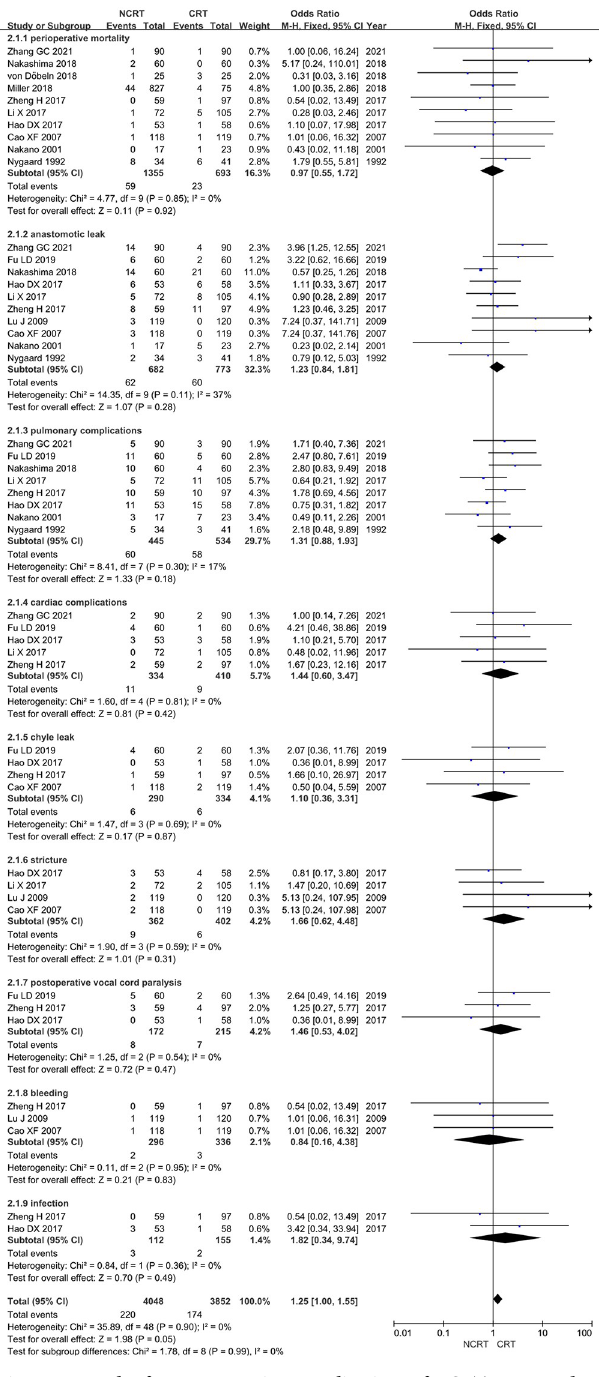
PLOS ONE | https://doi.org/10.1371/journal.pone.0271242 August 5,